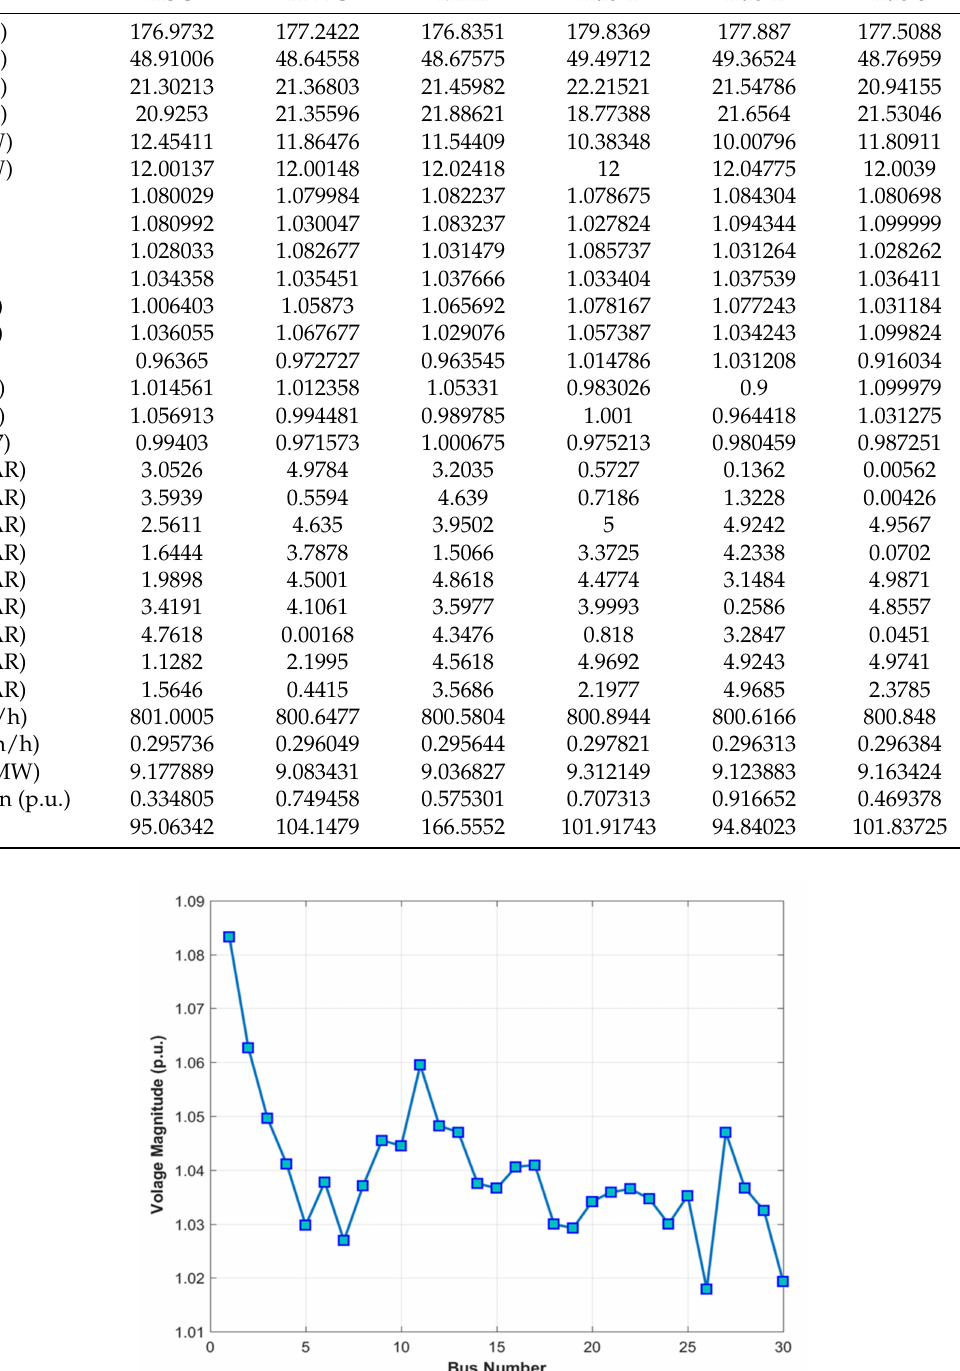
Figure 4. The voltage profile of the MRao-2 for the best solutions of case